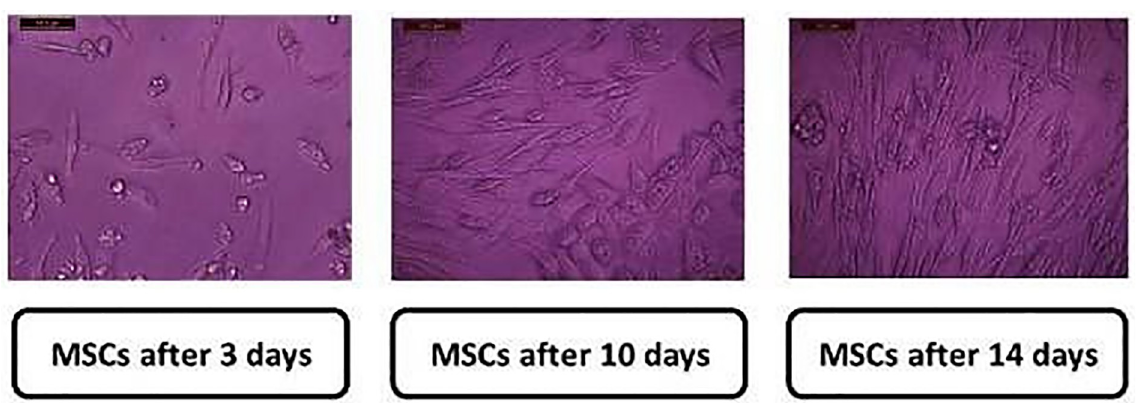
Fig 8. Characterization of isolated bone marrow stem cell of rat which was used after 14 days (mature stage) X200.